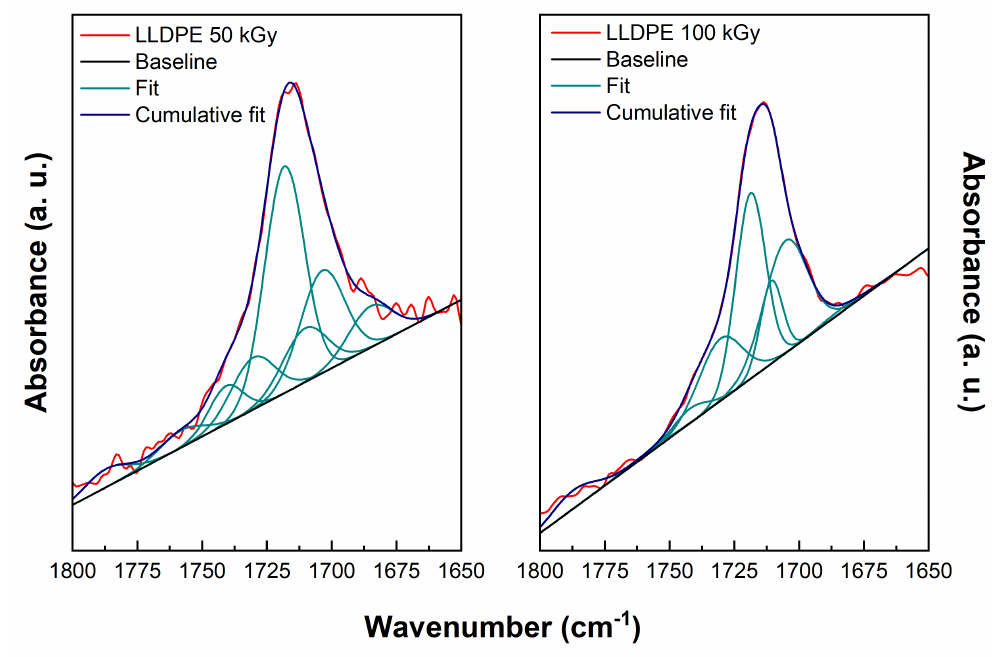
Figure 3. Deconvolution results for LLDPE irradiated at 50 kGy (left) and 100 kGy (right). FWHM of the fitting Gaussians are constrained between 10 and 20 cm − 1 . The corresponding numerical results are given in Table